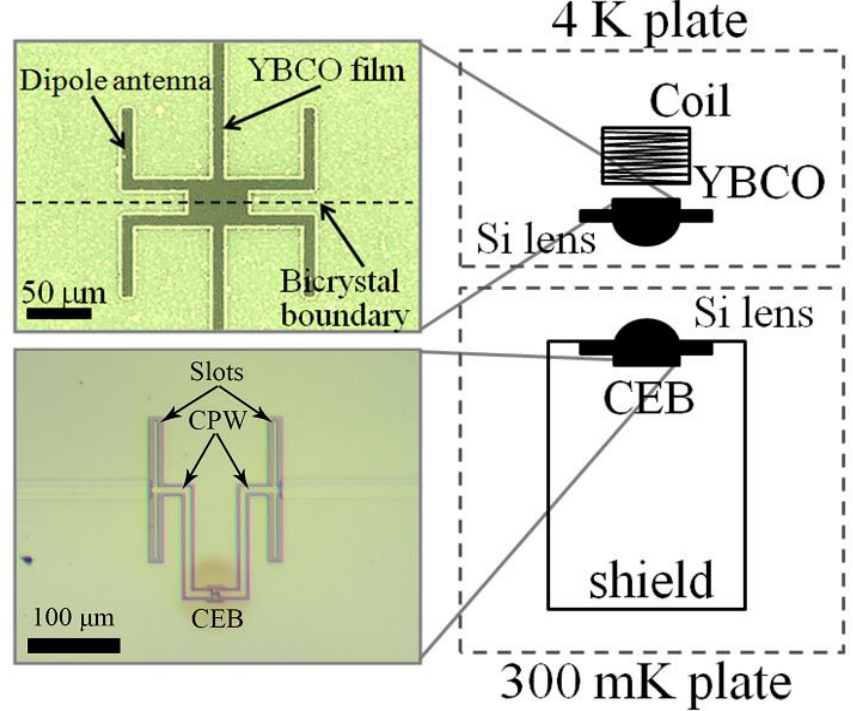
Figure 3. The experimental setup view, its schematic representation, and samples design.